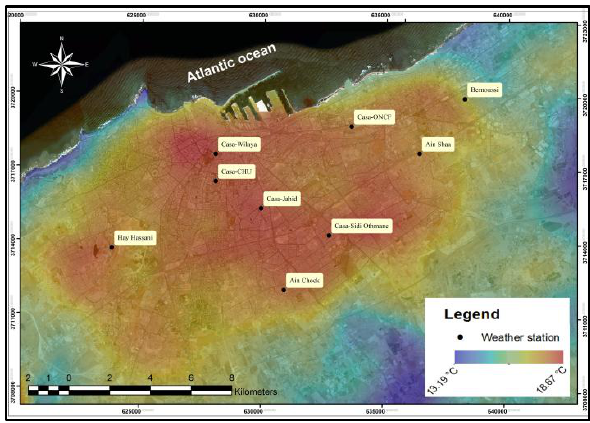
Figure 10. Spatial distribution of minimum air temperature estimated from nighttime MODIS observation during the 3th of august 2012